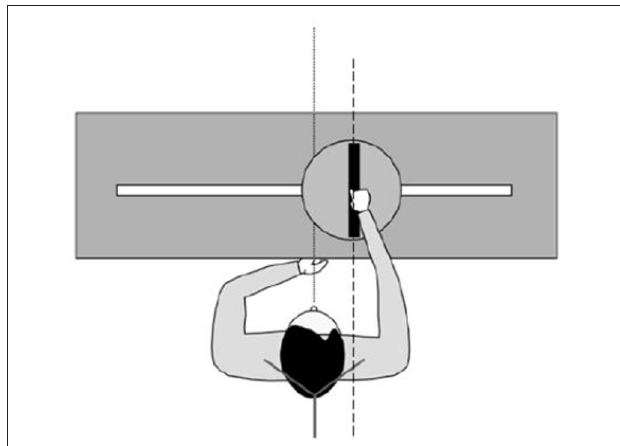
FIGURE 1 | Apparatus and participant positioning for assessing the